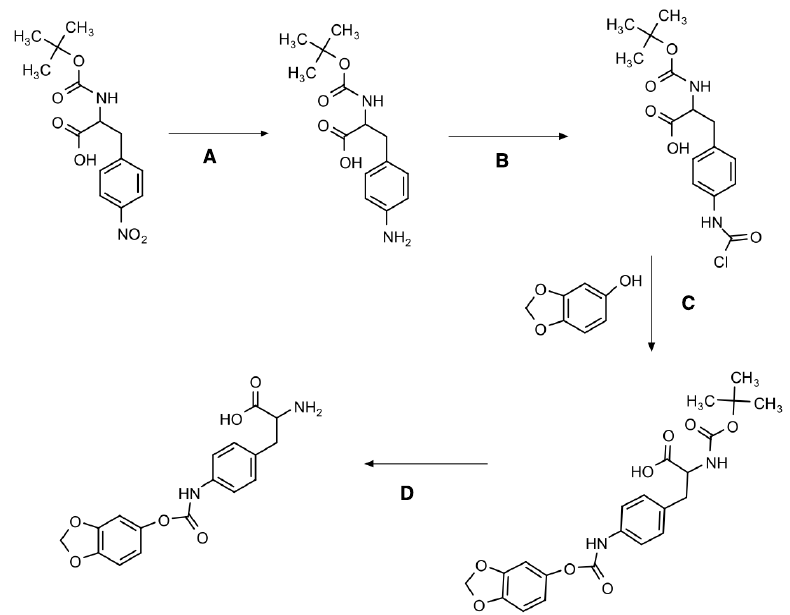
Figure 1. Synthesis diagram of 4 - sesamol carbamate - L - phenylalanine prodrug with four multi - step reactions . Reagent and conditions: ( A ) Palladium, methanol, H 2 gas, overnight; ( B ) triphosgene, triethylamine, anhydrous DCM, 1 h; ( C ) sesamol, triethylamine, tetrahydrofuran, overnight; and ( D ) trifluoracetic acid, anhydrous DCM, 4 h .